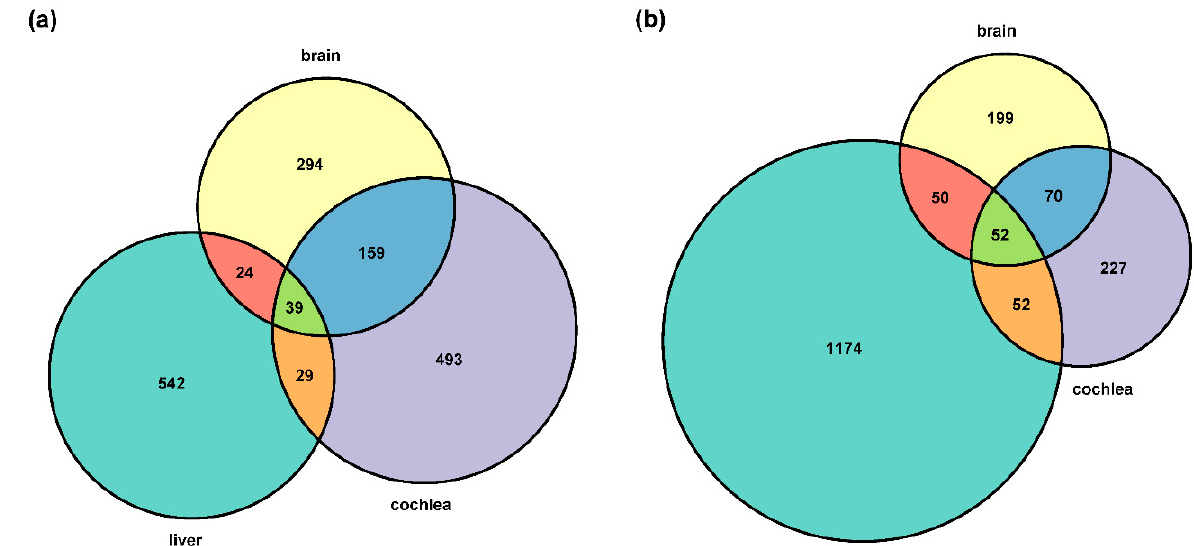
Figure 1. Venn diagram showing the numbers of intersecting differentially expressed genes (DEGs) under natural selection among the three organs in ( a ) the inter-specific and ( b ) inter-subspecific comparison. The labels ‘cochlea’, ‘brain’, and ‘liver’ indicate the cochlea, brain, and liver samples in each comparison, respectively. The size of diagram is proportional to quantity. Colors have no meaning.